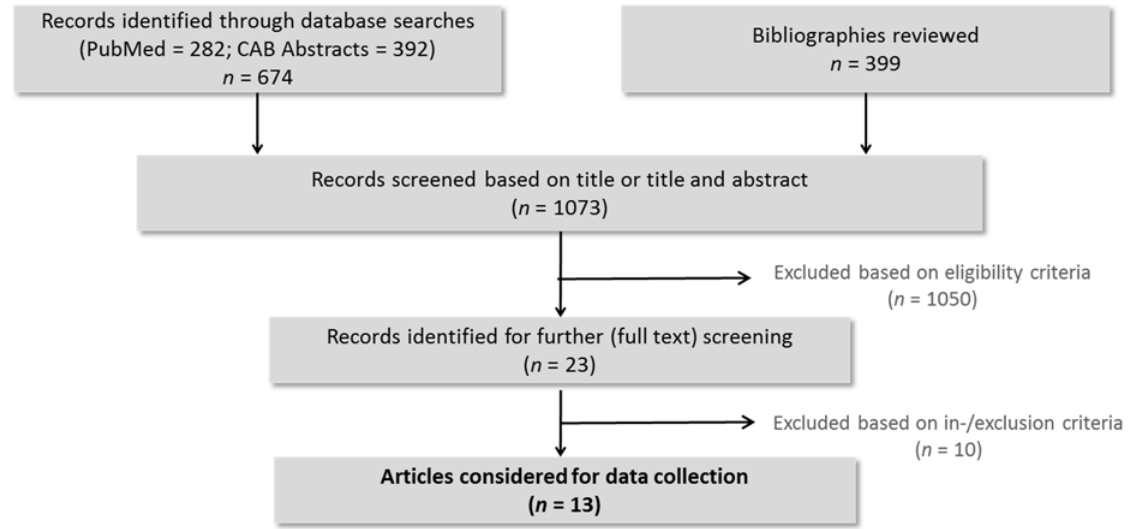
Figure 1. Flow chart of the study selection process, illustrating the study selection process according to PRISMA (Preferred Reporting Items for Systematic Reviews and Meta-Analysis).